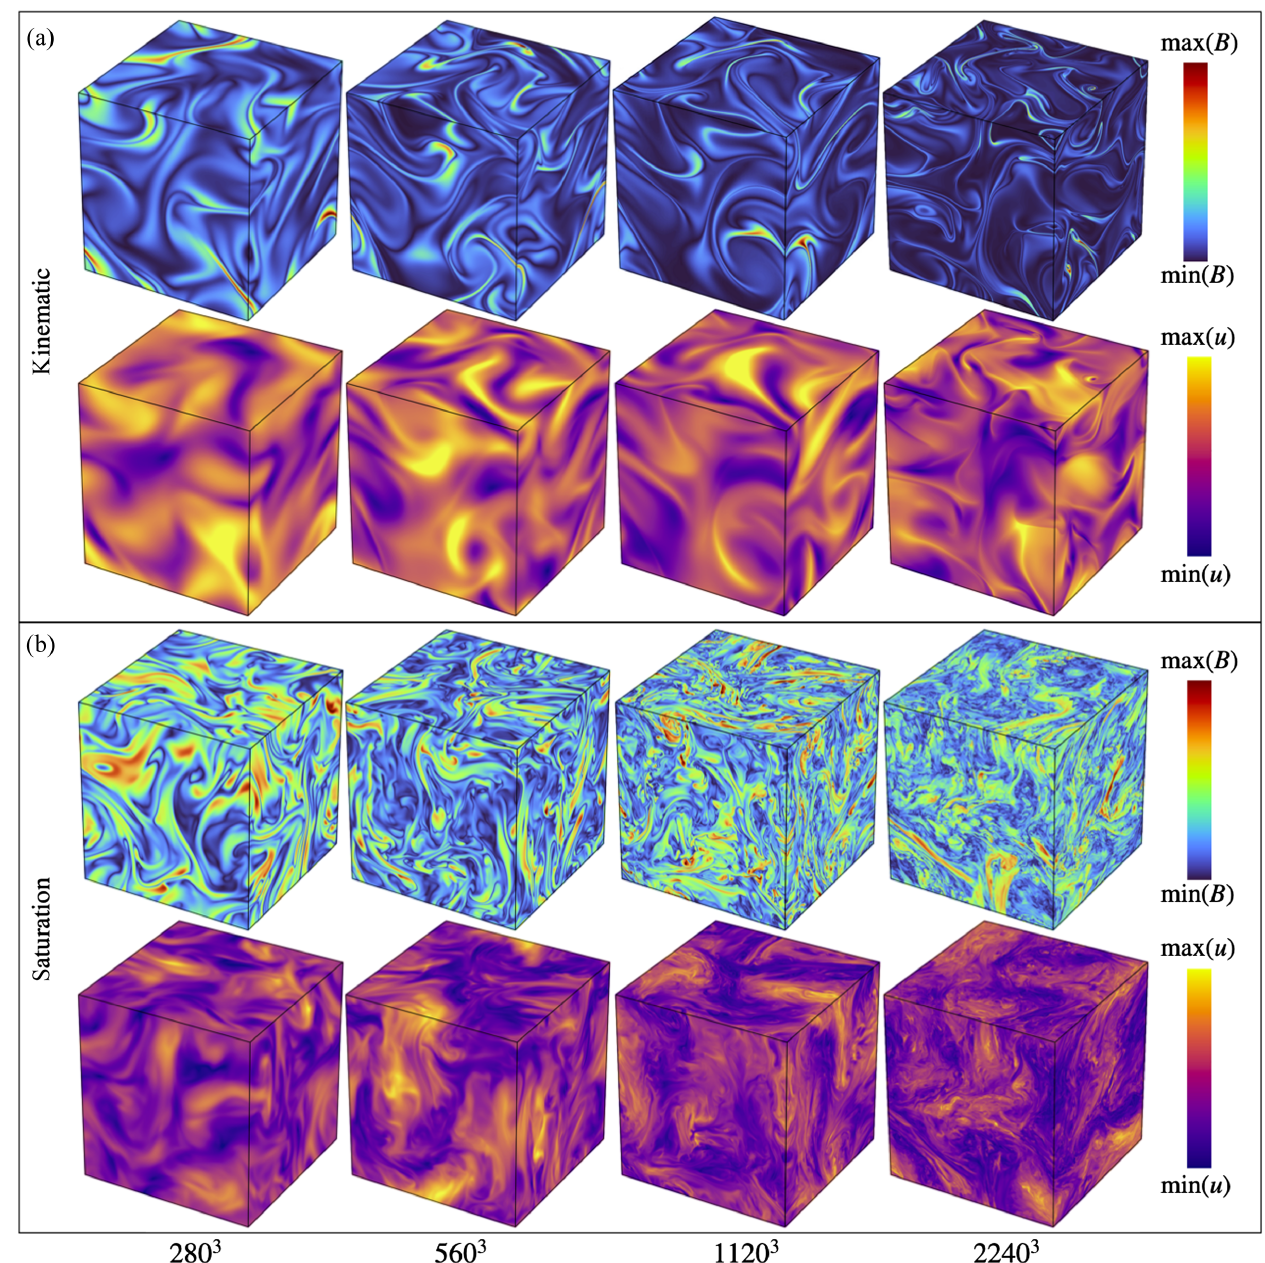
FIG. 2. Qualitative comparison of magnetic-field strength B (top row) and speed u (bottom row) during both the kinematic stage (a) and in saturation (b) taken at fixed Pm ¼ 10 from runs a2, b2, c2, and d2. Both quantities are normalized in each snapshot so that the color bars range linearly between their instantaneous minimum and maximum values in the domain. The resolution, and thus Rm, increases from left to right as